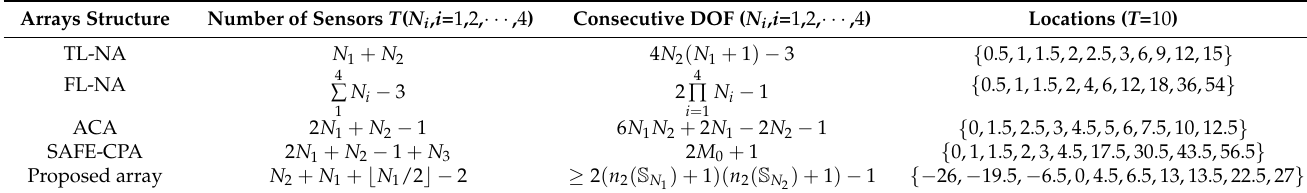
Figure 5. cDOF comparisons of different arrays. Table 3. Comparisons of different cDOF versus array structures.